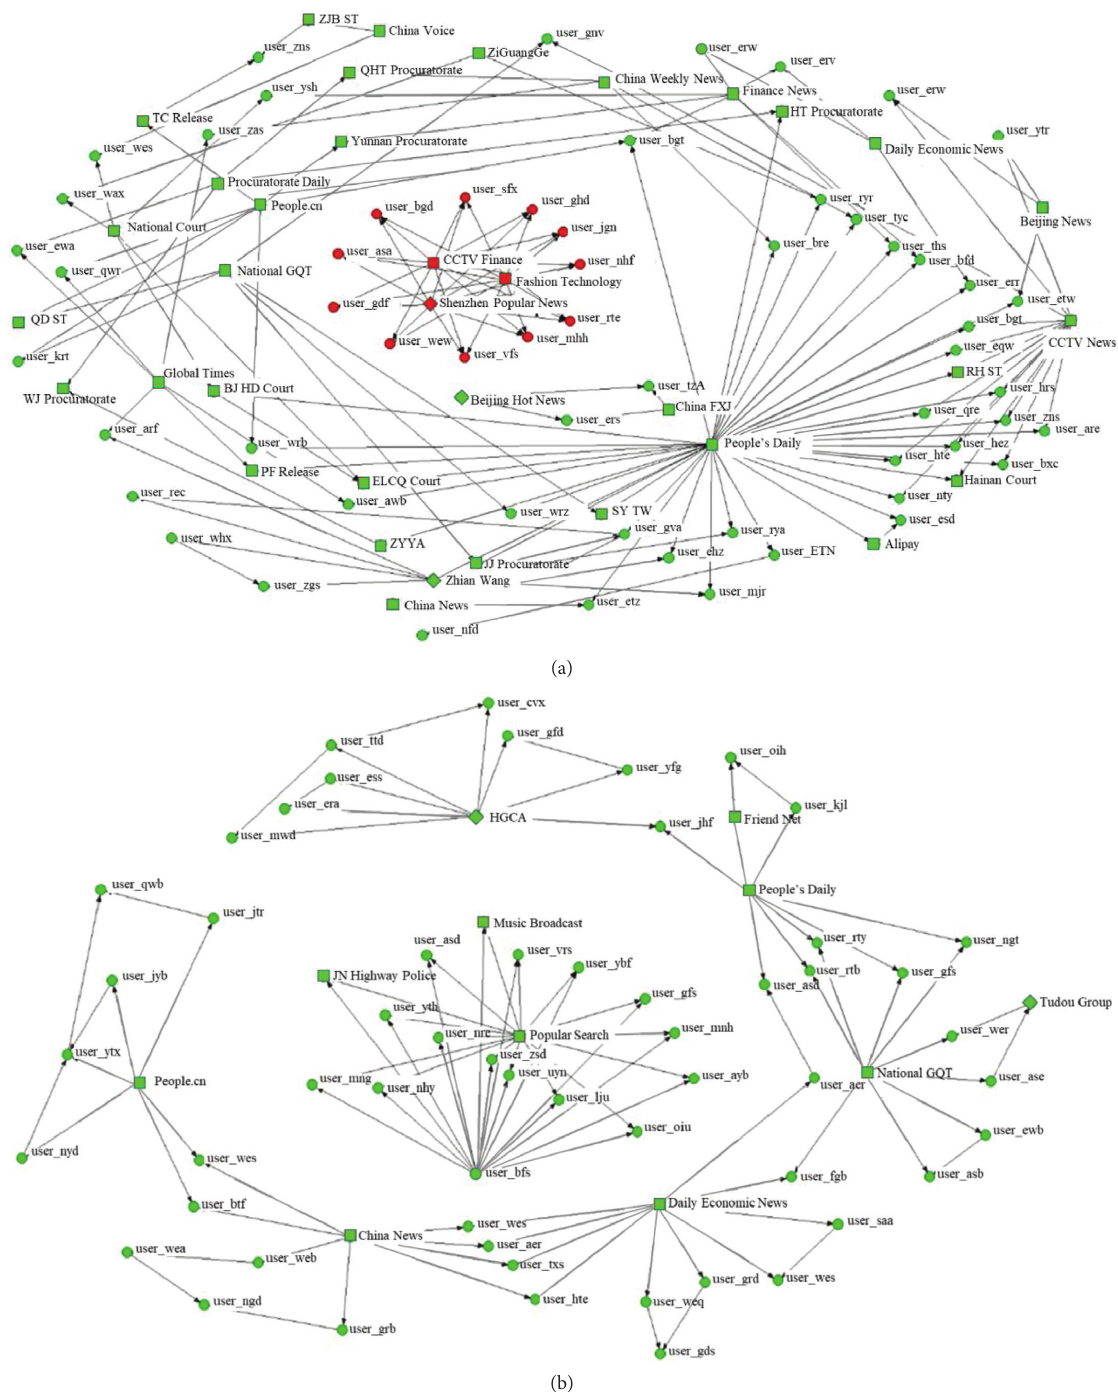
Figure 7: The core-periphery structure measured by K-core decomposition in (a) GCPN and (b)